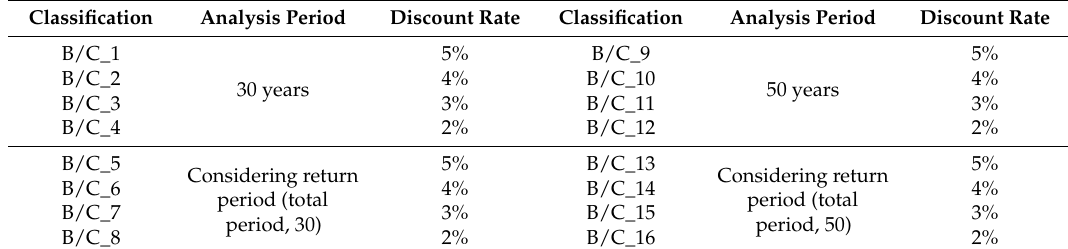
Figure 3. Benefit/cost (B/C) results of project sites. Table 9. Evaluation condition.